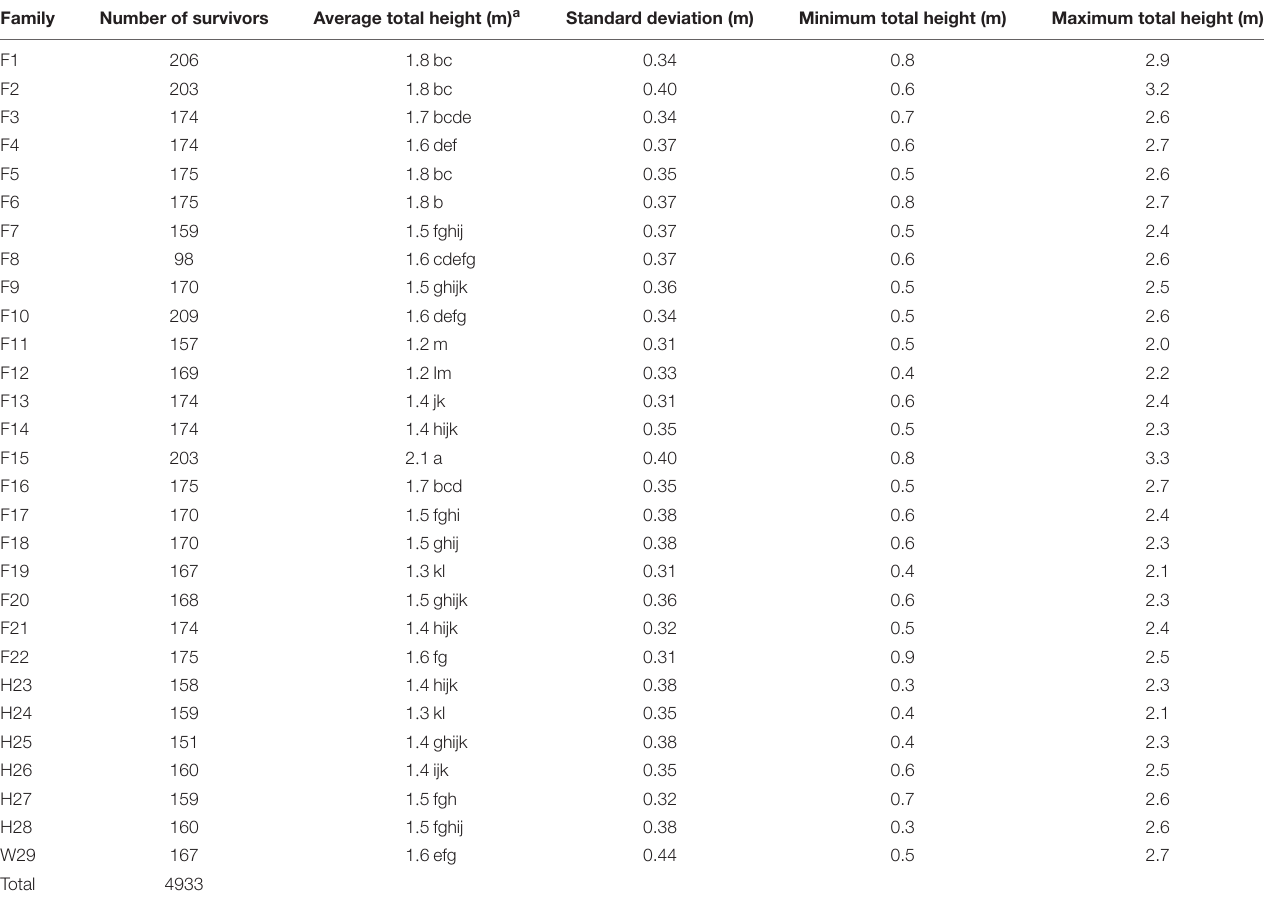
TABLE 4 | Three-year total heights of surviving pines from the 1969 outplanting in Compartment 3 of the Crossett Experimental Forest, measured in 1972 and averaged by family (five replicates, including the five arboretum plots merged with Replicate #5). Family Number of survivors